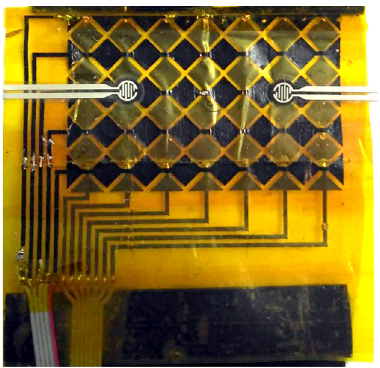
Figure 7: Position of the force - resistive sensors in the touch matrix.